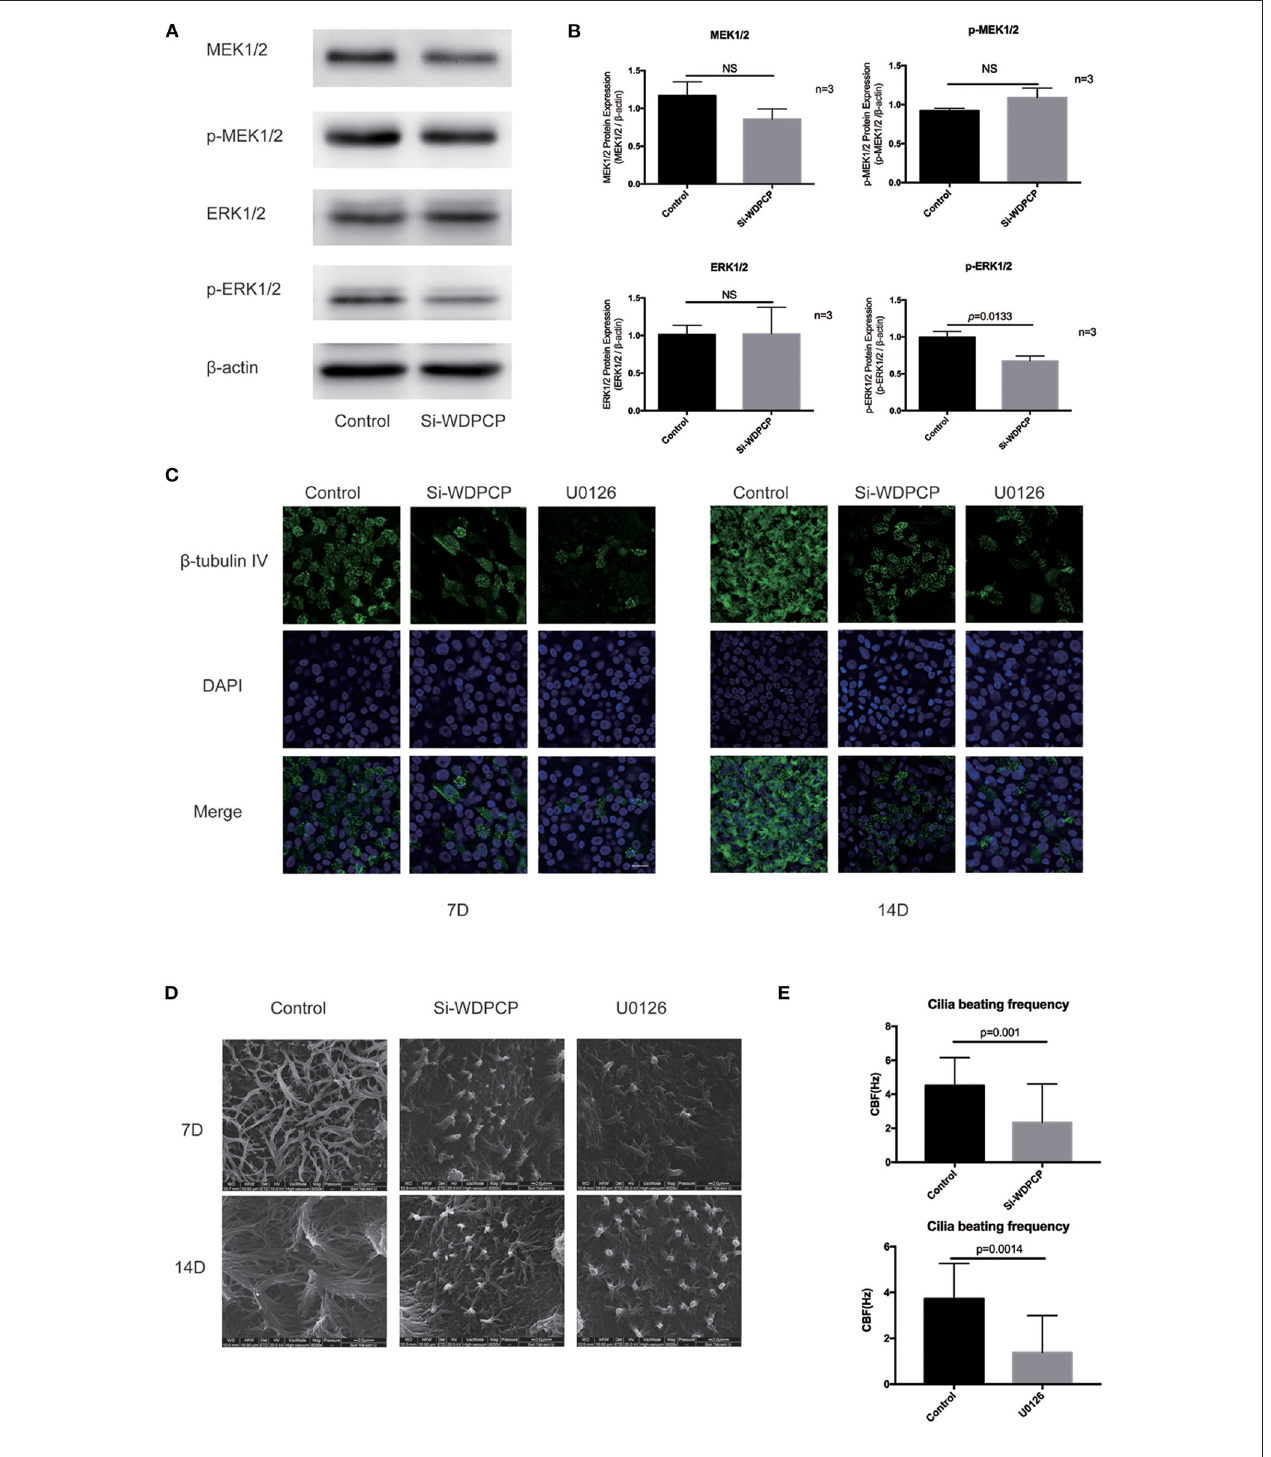
FIGURE 2 | WDPCP regulated ciliogenesis and cilia beating through the MAPK/ERK pathway in HSECs. (A,B) The expression of p-ERK1/2 was decreased in Si-WDPCP HSECs ( n = 3) by Western blot and densitometry analysis. (C) Immunofluorescence images showed the decrease of cilia length and quantity in HSECs that lacked WDPCP and U0126-treated HSECs. Scale bar: 20 µ m. (D) SEM images also showed that the cilia length and quantity were decreased in HSECs that lacked WDPCP and U0126-treated HSECs. Scale bar: 2 µ m. (E) Cilia beating frequency was reduced on Day-14 in HSECs that lacked WDPCP and U0126-treated HSECs ( n =